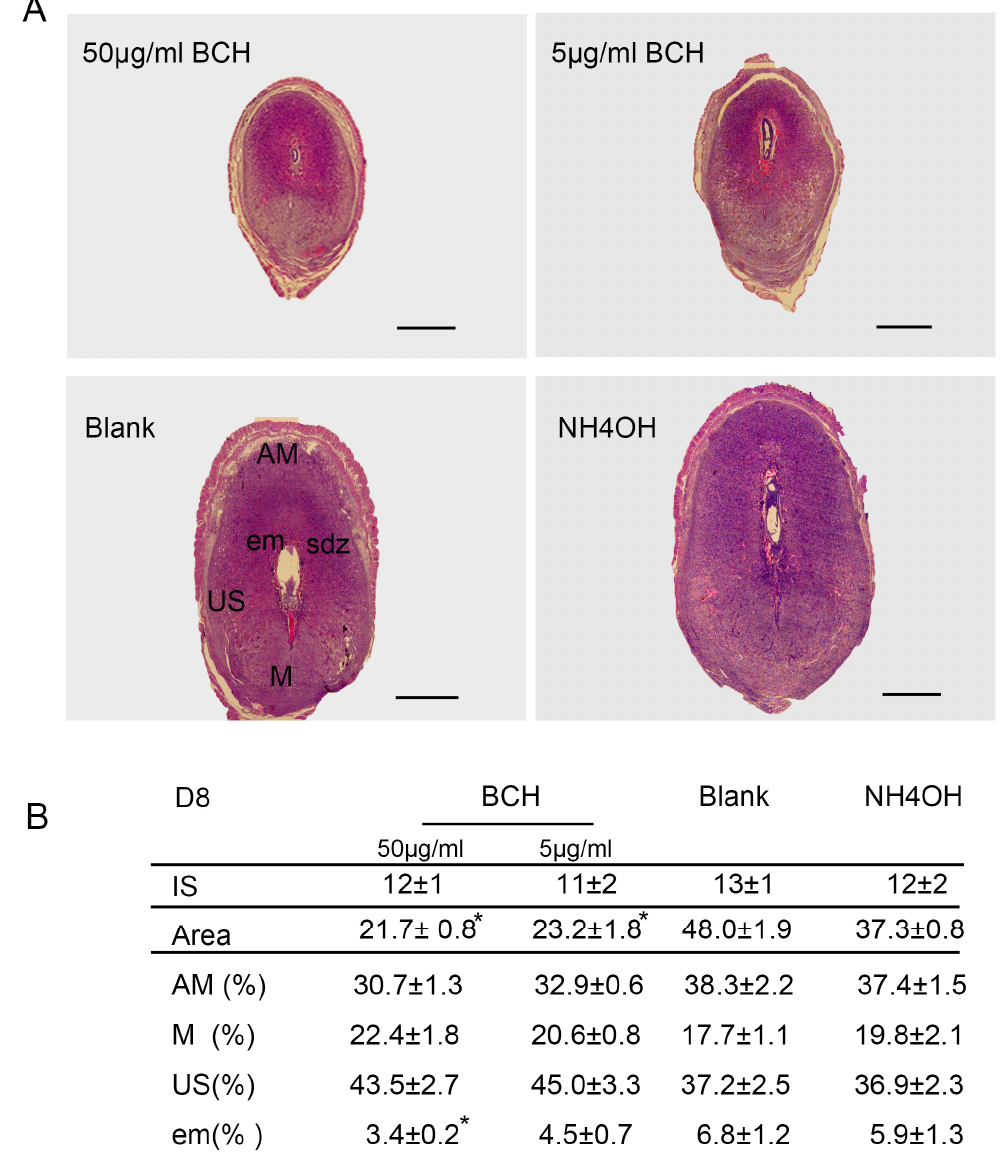
Figure 5. Morphology effects of BCH on D8 implantation sites after uterine horns injections on D4. ( A ) H&E staining on D8 from 50 µ g/mL BCH, 5 µ g/mL BCH, NH 4 OH (employed as a solvent) treated mouse, and normal pregnancy without any treatment; ( B ) Quantitative analysis. Table shows the number of implantation sites, total area of decidua and the percentage of tissue areas corresponding to the different regions within the ISs relative to the area of total decidua. Image J software analyzed the data that represented mean fold change ± SEM from at least 3 independent treatments.* p < 0.05. AM, antimesometrial decidua; M, mesometrial decidua; US, undifferentiated stroma; sdz, secondary decidual zone; em embryo IS, implantation sites. Bar = 75 μ m. There were 15 mice sacrificed per group.